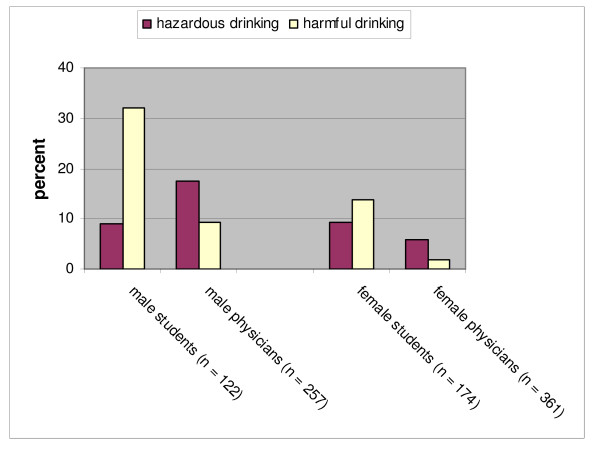
Proportions of hazardous and harmful drinking among medical students and physicians depending on gender.